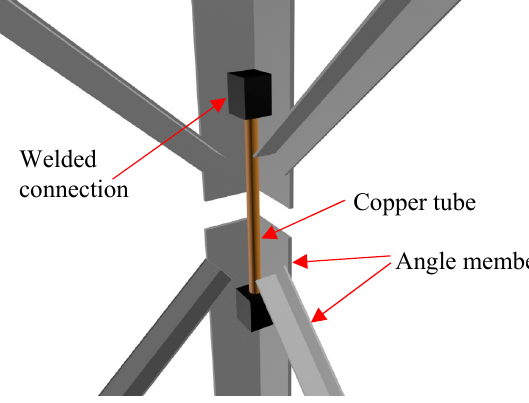
Figure 9. Detailed connection of copper tube and angle members.